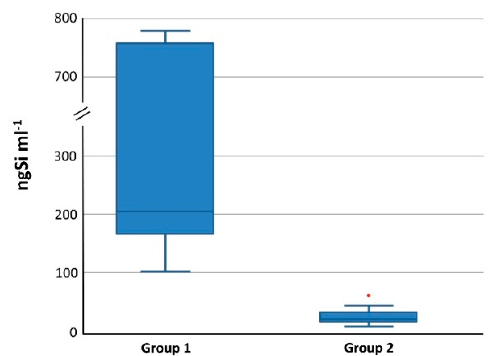
Figure 2. Box plots representing magnitude and variability of background Si concentration in method blanks (digestion reagent mixture after MW irradiation) obtained with standard vessel cleaning (Group 1) and the cleaning procedure used in this study, as described in Section 2.3.1 (Group 2). Outliers shown as red spots are unzoomed for Group 1 ( n = 2).